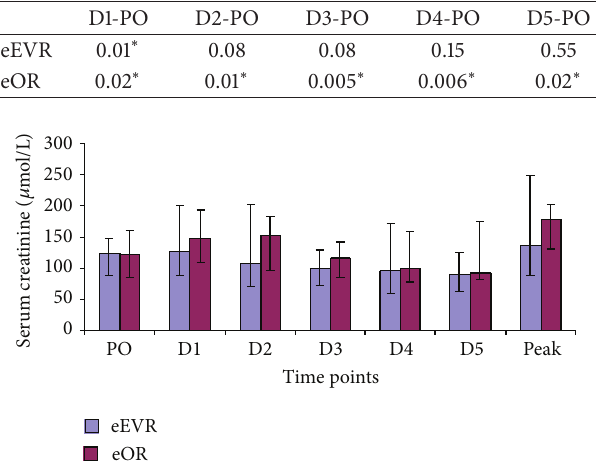
Figure 1: Serum urea levels in the eEVAR versus eOR groups at preoperatively (PO, 𝑃 = 0.442 ), day 1 (D1, 𝑃 = 0.429 ), day 2 (D2, 𝑃 = 0.134 ), day 3 (D3, 𝑃 = 0.240 ), day 4 (D4, 𝑃 = 0.121 ), day 5 (D5, 𝑃 = 0.062 ), and the peak ( 𝑃 = 0.328 ) expressed as median and IQR (Mann-Whitney 𝑈 test).